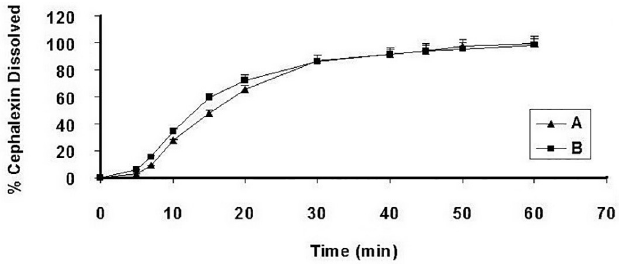
FIGURE 2 - Chromatogram of blank human urine (1), blank human urine with cephalexin 25.0 µg.ml -1 (2), 50.0 µg.mL -1 (3) and 100.0 µg.mL -1